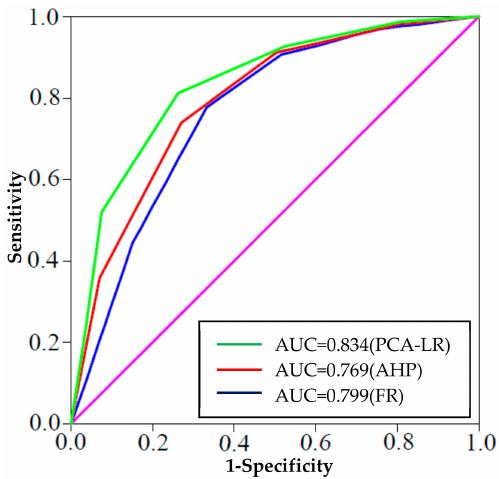
Figure 11. Receiver operating characteristic (ROC) curve of the